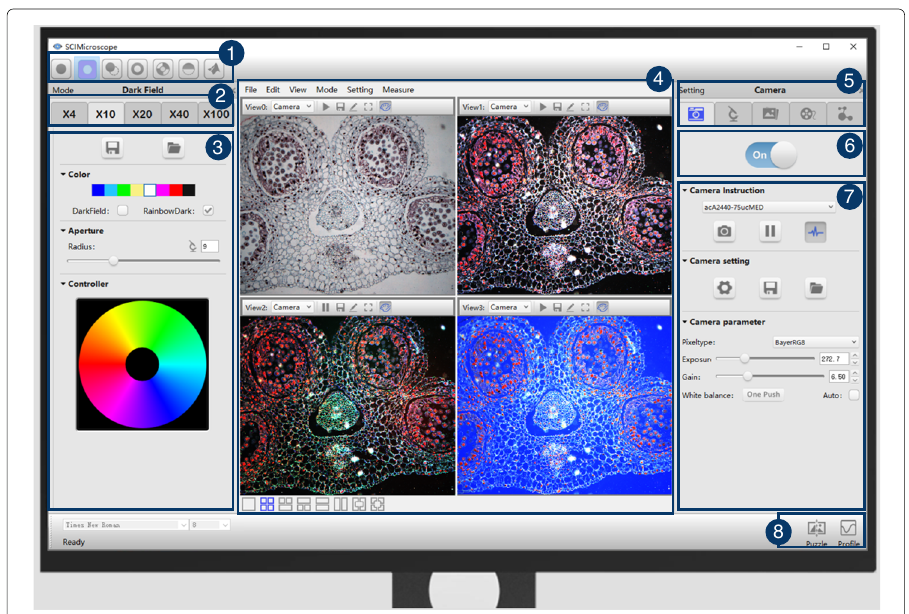
Fig. 33 Software interface, module, and